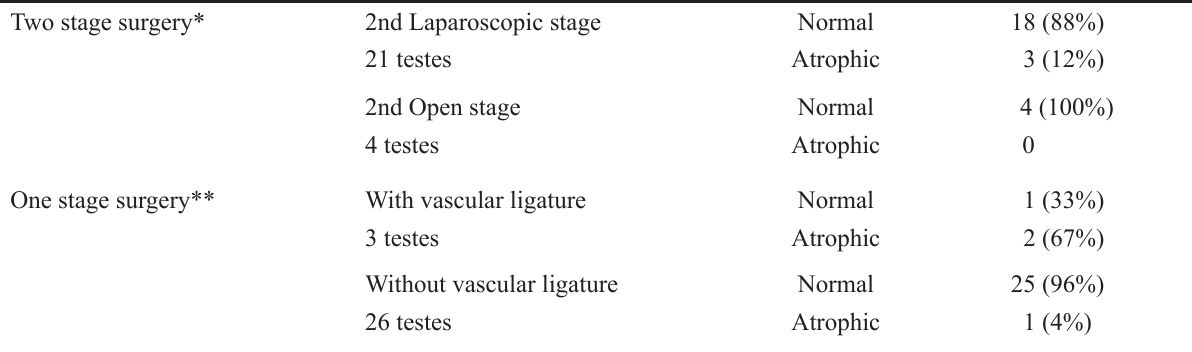
Table 4 – One stage vs. two stage Fowler-Stephens. Two stage